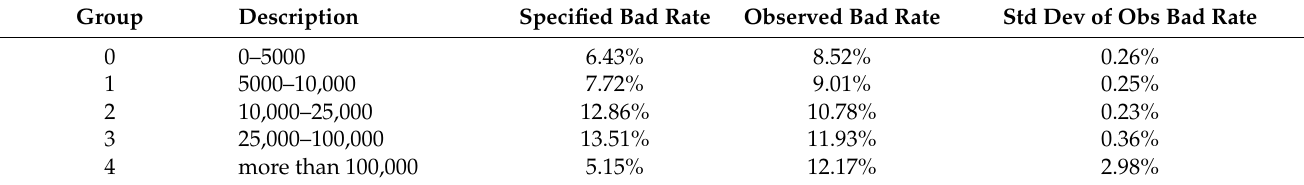
Table A9. Amount outstanding.